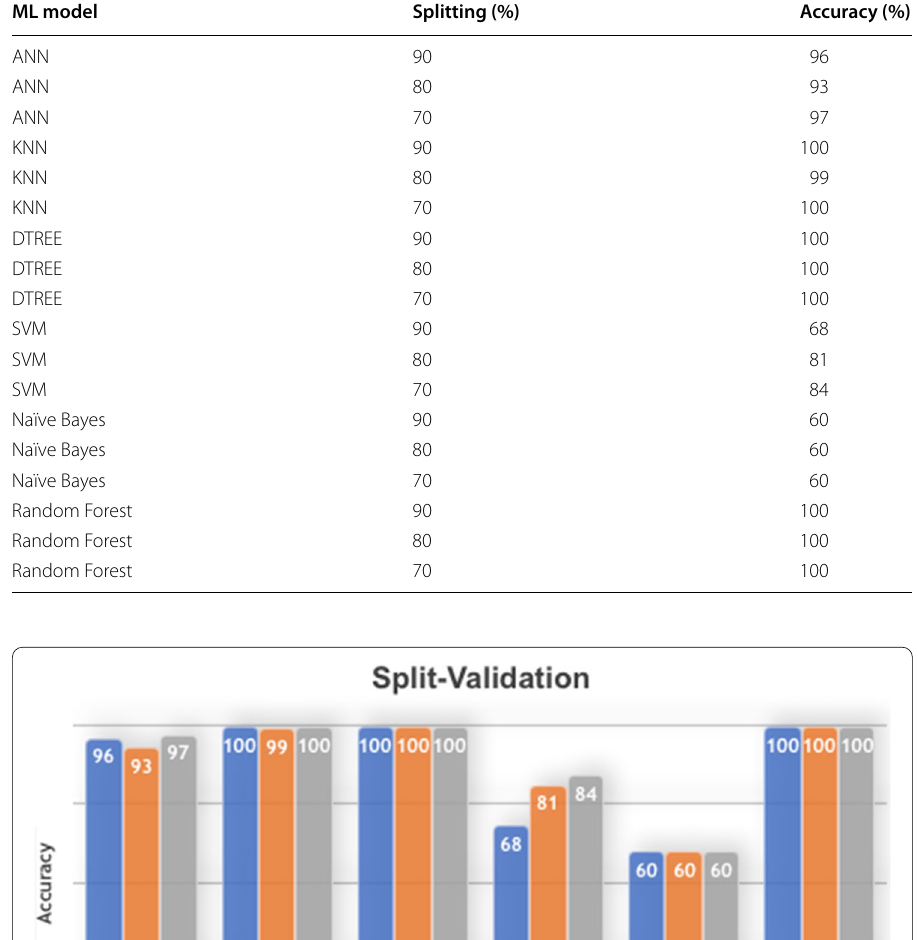
Table 23 Split-Validation result for ML models